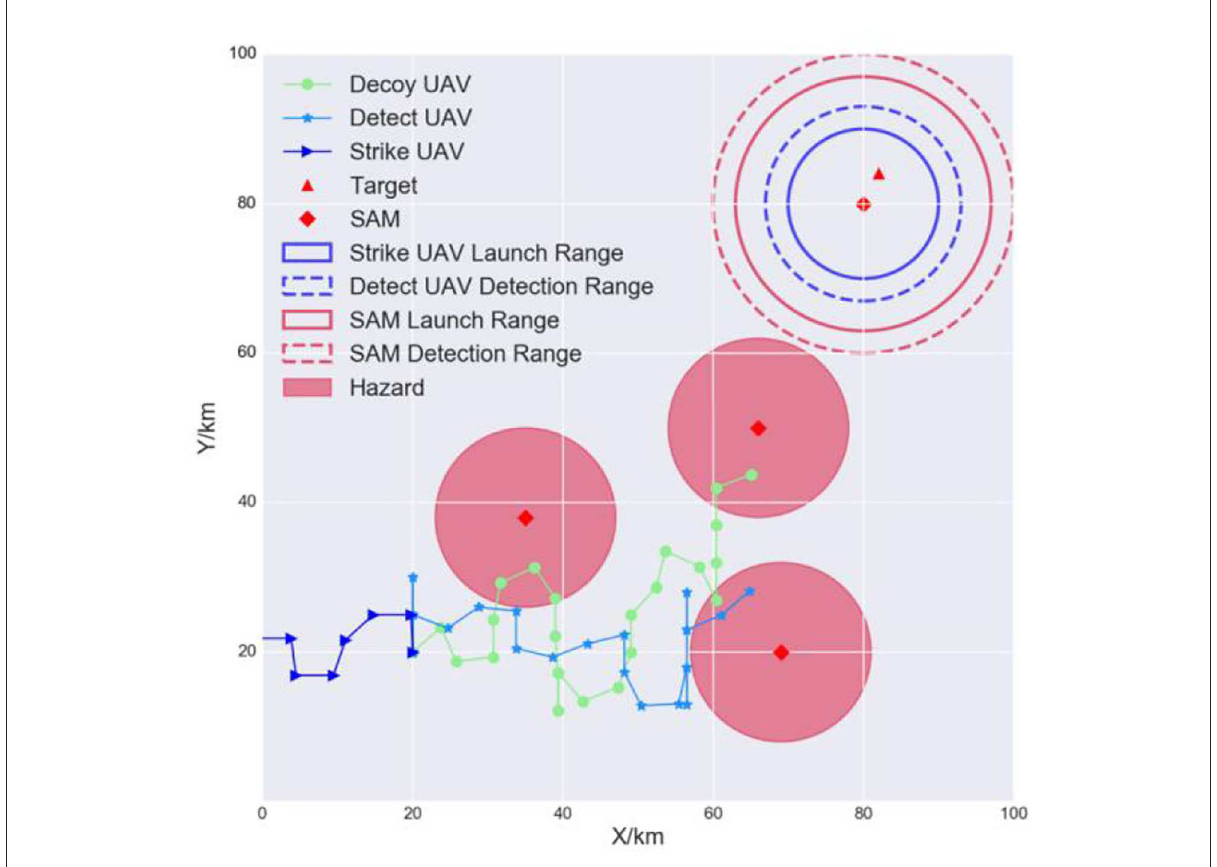
FIGURE6 Simulation